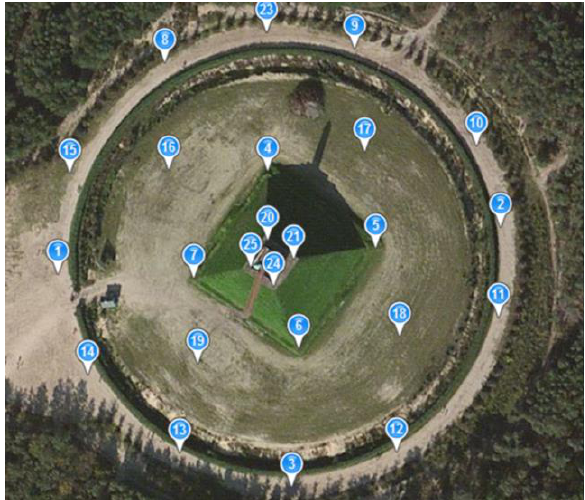
Figure-3: Overview of Austerlitz test area with locations of the ground control